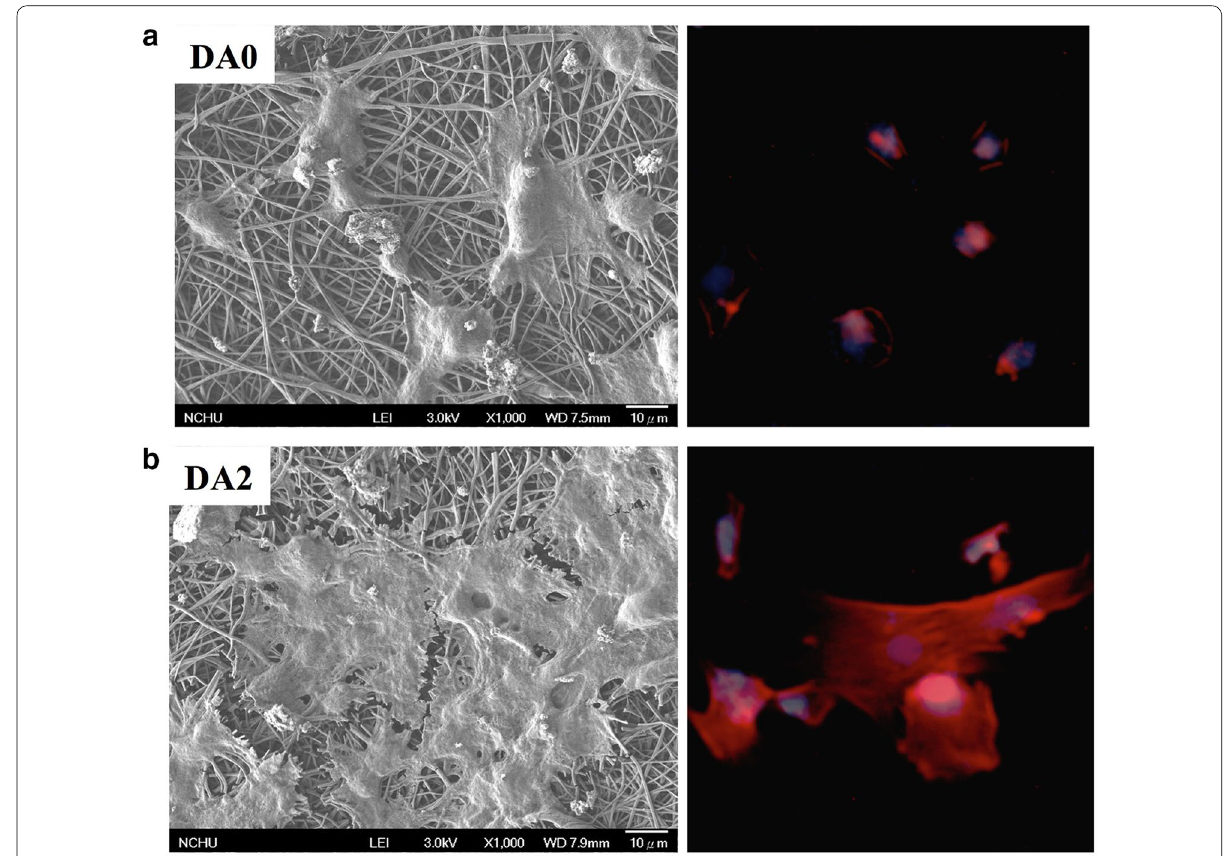
Fig. 4 a SEM and immunofluorescence images of hADSCs attached on PLA and b PDA/PLA nanofibers. Reproduced with permission from [109],